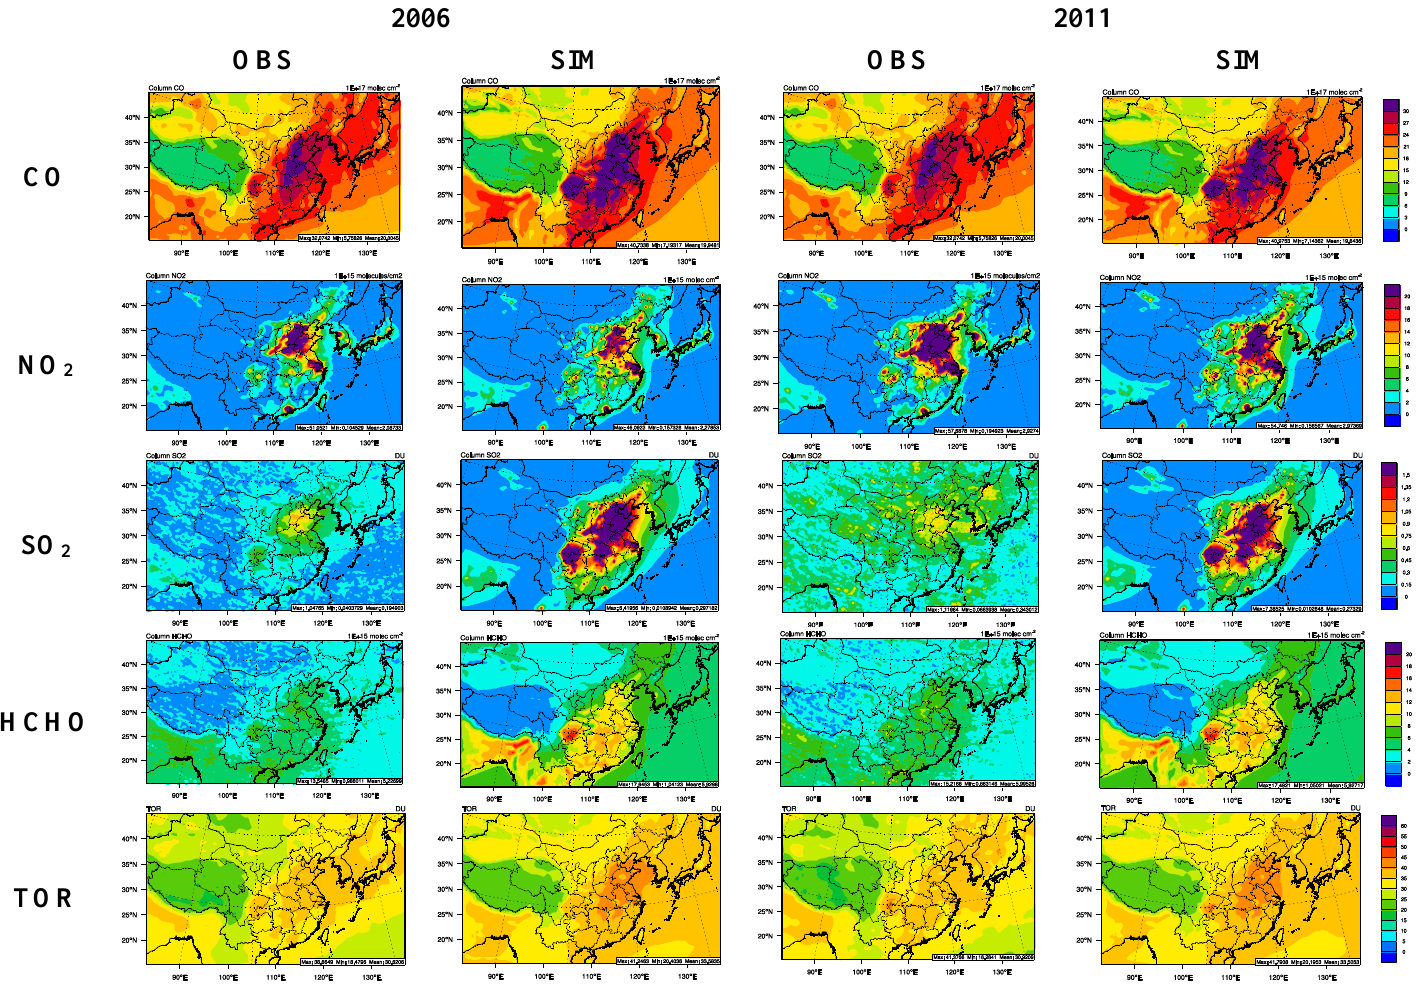
Figure 8. Spatial distributions of annual mean observed and simulated column CO, NO 2 , SO 2 , HCHO, and TOR for the 2006 and 2011 simulations with